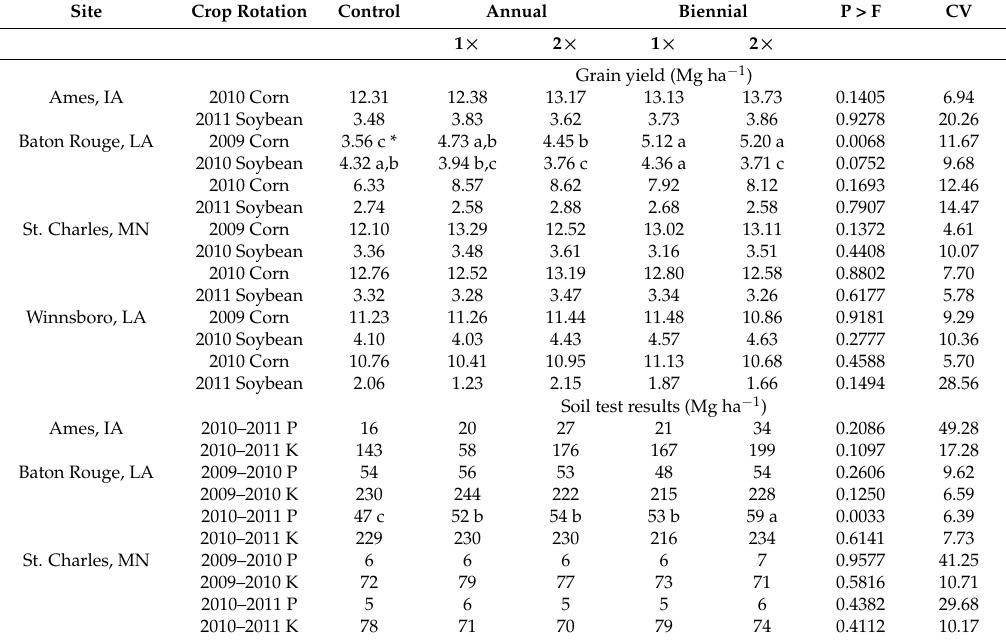
* Letters following numbers within a row represent differences between treatments at the p ≤ 0.10